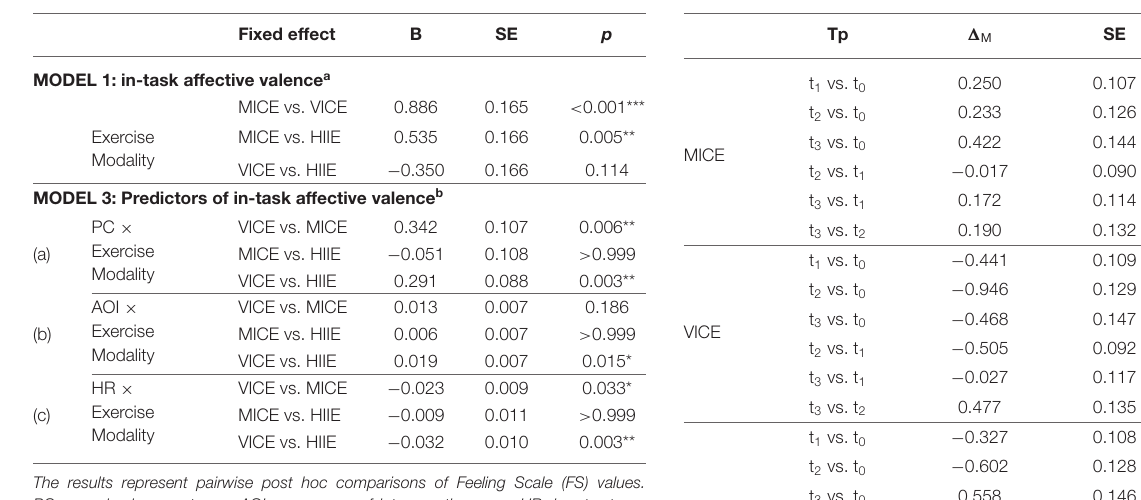
TABLE 4 | Comparisons of affective valence at four time points within exercise